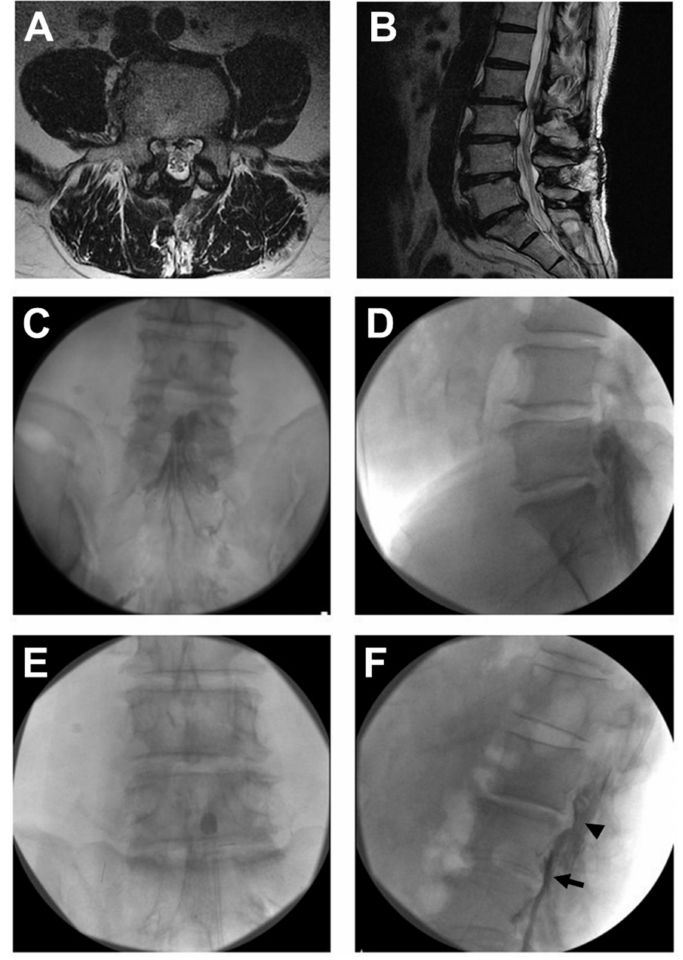
Figure 2. Percutaneous epidural adhesiolysis combined with balloon decompression in a patient with lumbar post-laminectomy syndrome. A 61-year-old male with a history of L4-5 partial laminectomy and flavectomy 1 year prior underwent combined epidural adhesiolysis and balloon decompression. ( A ) Adhesive cauda equina is shown in a cross-sectional magnetic resonance imaging (MRI) image at L4-5 level. ( B ) A sagittal MRI image of identical patient shows well-decompressed state in L4-5 level. ( C ) Anteroposterior fluoroscopic view showing a definite contrast filling defect in the previously operated L4-5 level. ( D ) A lateral fluoroscopic image showing a filling defect above the L4-5 level. ( E ) The inflatable balloon catheter placed in the suspected adhesion site and balloon filled with the contrast medium. ( F ) Contrast flow detected above the L4-5 level after the balloon procedure (arrowhead). The catheter is noted (arrow) in the anterior epidural